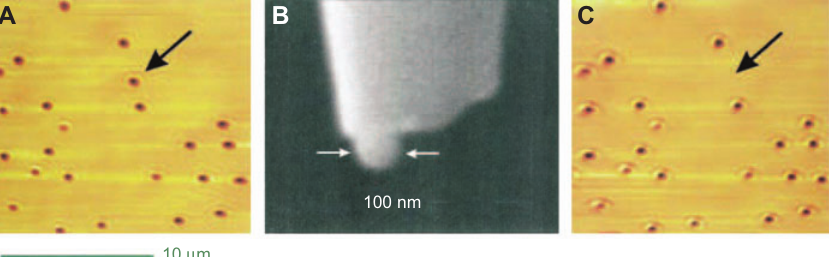
Figure 12 Colloidal gold nanosphere attached to a glass fi ber tip. Reprinted with permission from [49] . Copyright 2001, John Wiley & Sons